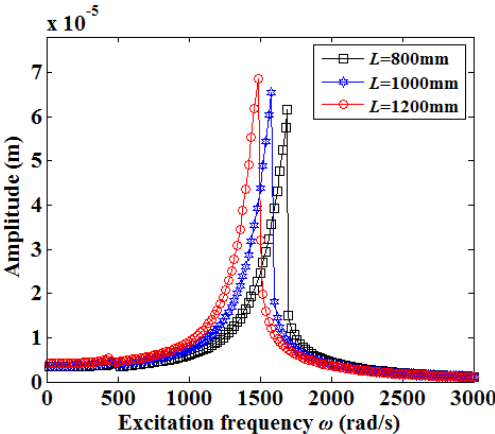
Figure 16. Amplitude-frequency curves of the feed system for different length of screw shafts.